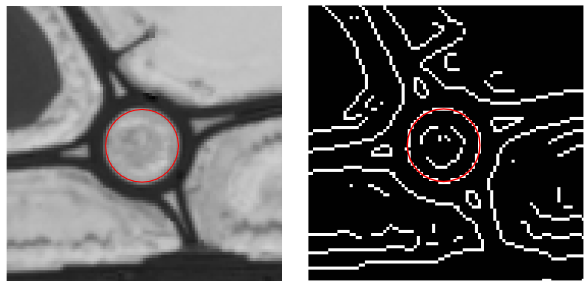
Figure 2. The detected circle (red) is superimposed on the NDVI image (left) and the detected edge